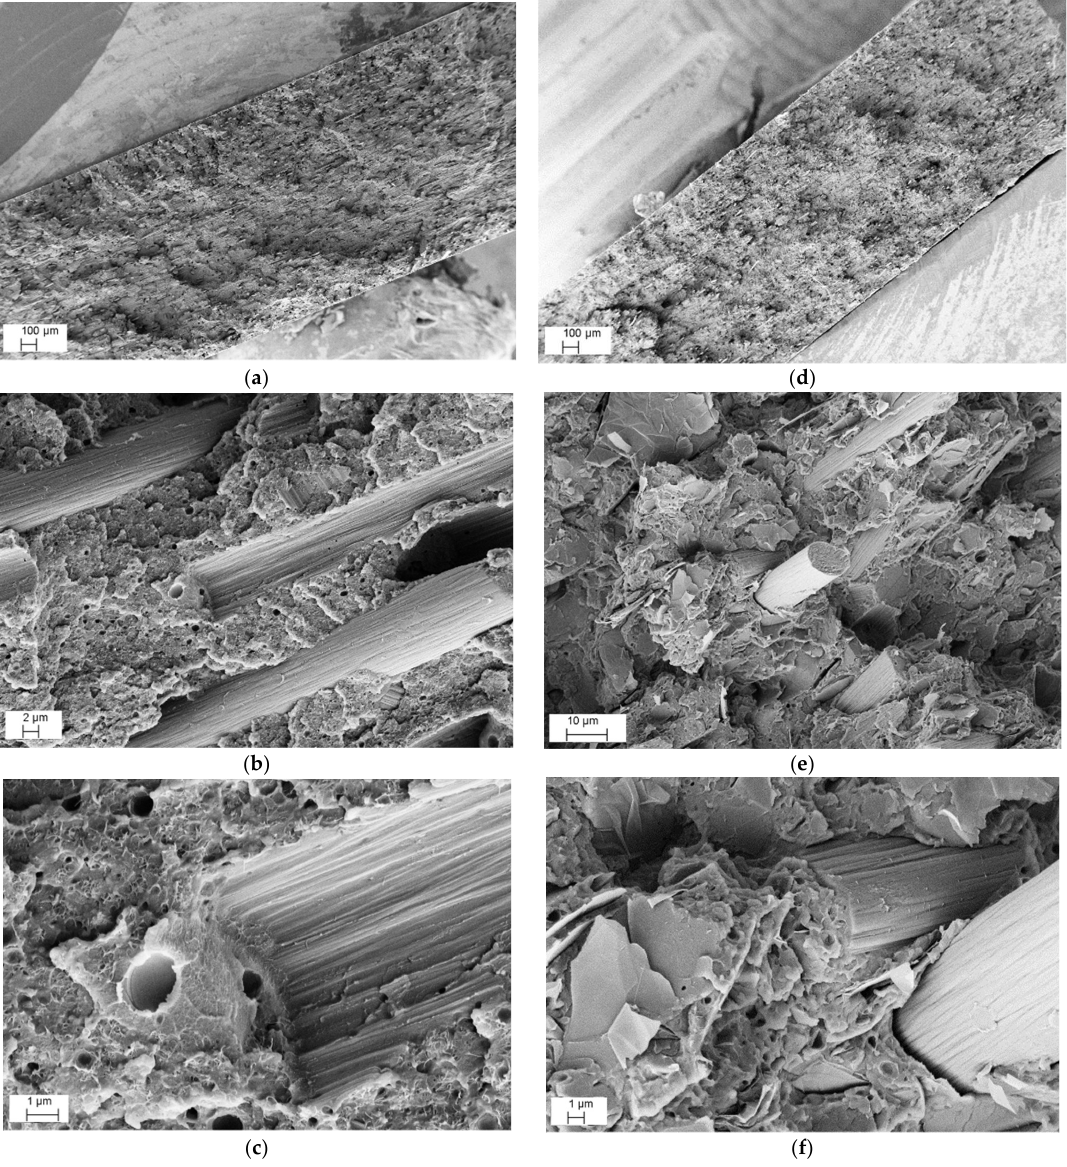
Figure 4. Representative FESEM micrographs at various magnifications of fracture surface of CM_MCF20-CNT3 ( a – c ) and CM_MCF20-GNP6 composite ( d – f ) plates produced by compression molding.